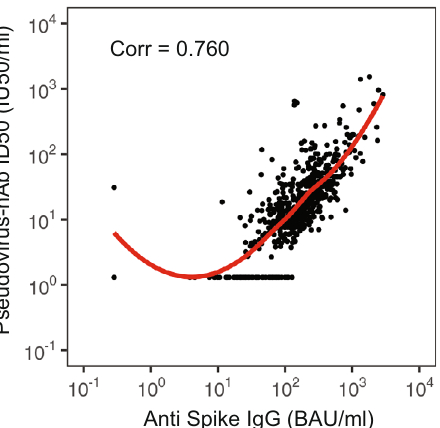
Fig. 2 Scatterplot of D57 spike IgG vs. D57 pseudovirus (PsV)-nAb ID50 values for baseline SARS-CoV-2 negative vaccine recipients in the immunogenicity subcohort. Corr, Spearman rank